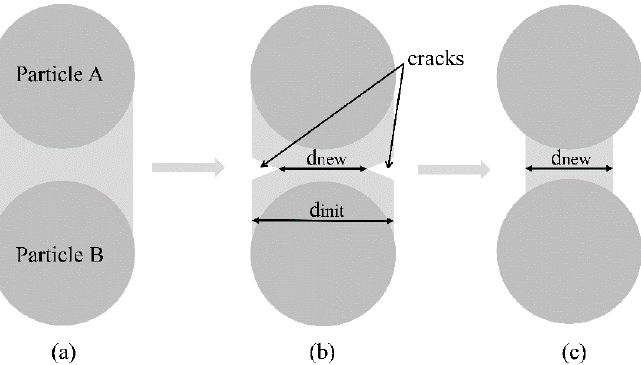
Figure 8. Bond damage caused by a small-scale crack and its implementation: ( a ) Undamaged bond connection of two primary particles; ( b ) A fatigue crack manifests in a reduction of the load-bearing cross-cut of a meso bond; ( c ) Representation of a fatigue crack in the model by a reduced bond diameter.